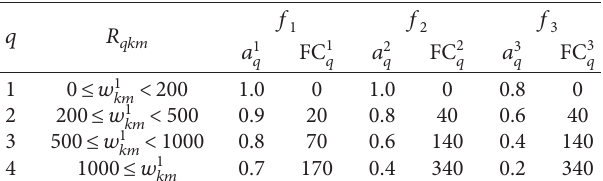
Table 9: Piecewise linear function slope.